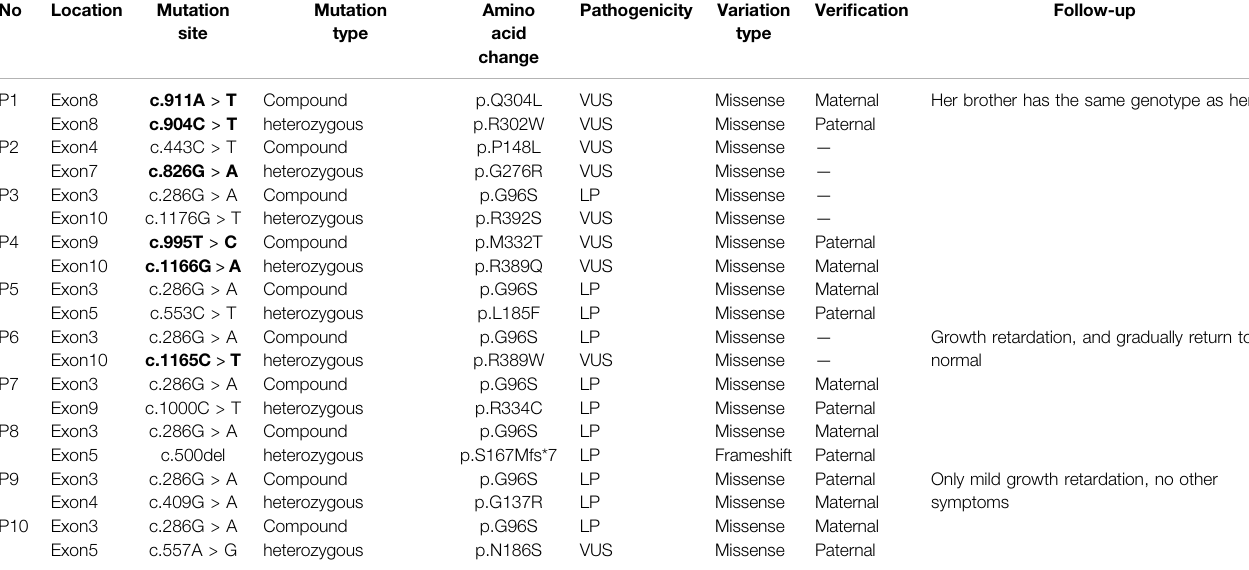
TABLE 2 | Results of ACAD8 gene mutation in 10 cases and follow